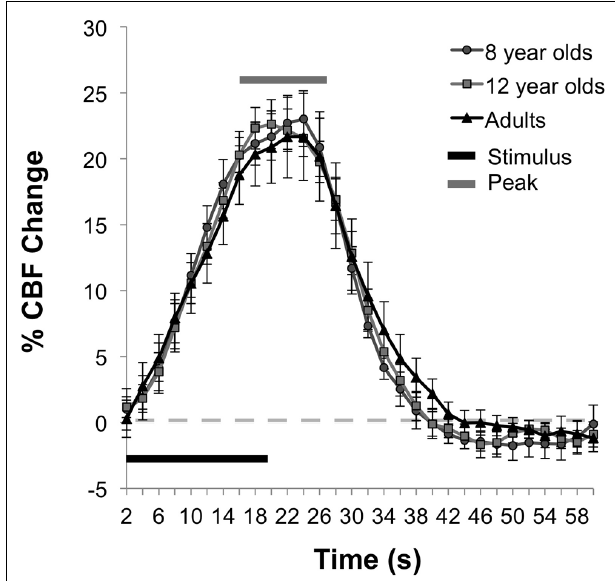
FIGURE 3 | Functional percent CBF change during motor task. The mean time series for each age group shows the percent of CBF change during stimulation relative to baseline.